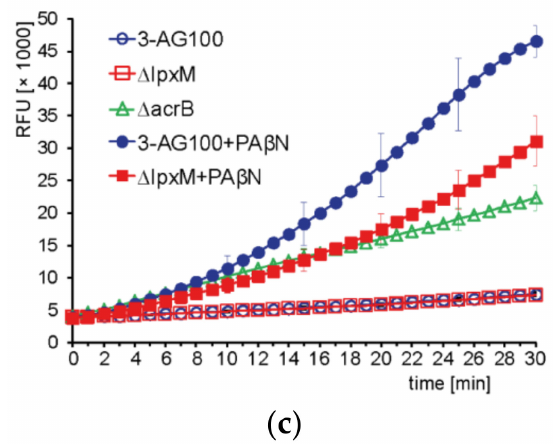
Figure 4. The kinetics of intracellular dye accumulation in mutant ∆ lpxM, parental E. coli 3-AG100, and an efflux-deficient ∆ acrB derivative from 3-AG100. RFU, relative fluorescence units; error bars indicate ± standard deviation (SD) from the mean. ( a ) Real-time efflux of Nile red. The arrow indicates the initiation of efflux by the addition of glucose to de-energized cells; ( b ) β -naphthylamine accumulation (degradation product of PA β N). Statistical significance (mutants vs. 3-AG100 at 45 min), p -values < 0.0001 ( n = 8); ( c ), Resazurin accumulation, determined by measurement of the intracellular degradation product resorufin. Statistical significance (3-AG100 with PA β N vs. ∆ lpxM with PA β N), p -value < 0.0001 ( n = 7). Table 1. Intracellular dye accumulation in the absence and presence of PA β N and polymyxin B nonapeptide (PMBN).